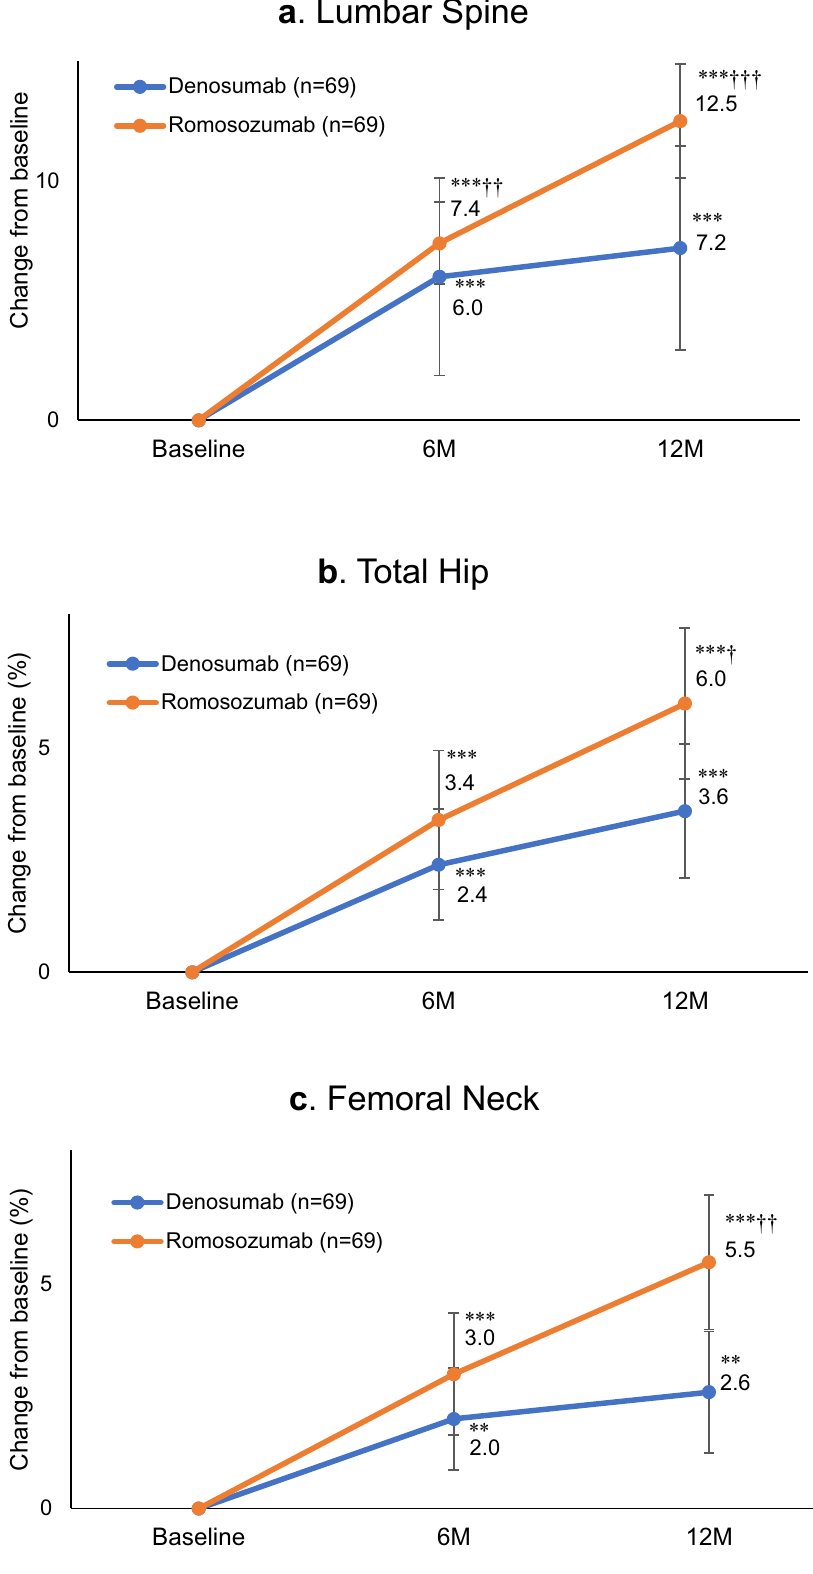
Figure 2. Mean percentage changes from baseline to 6 and 12 months (M) in bone mineral density (BMD) at the ( a ) lumbar spine, ( b ) total hip, and ( c ) femoral neck. Bars indicate the mean ± 95% confidence interval. **P < 0.01 and ***P < 0.001 versus baseline (Wilcoxon’s signed-rank test). † P < 0.05, †† P < 0.01, and ††† P < 0.001 versus denosumab (Wilcoxon’s rank-sum